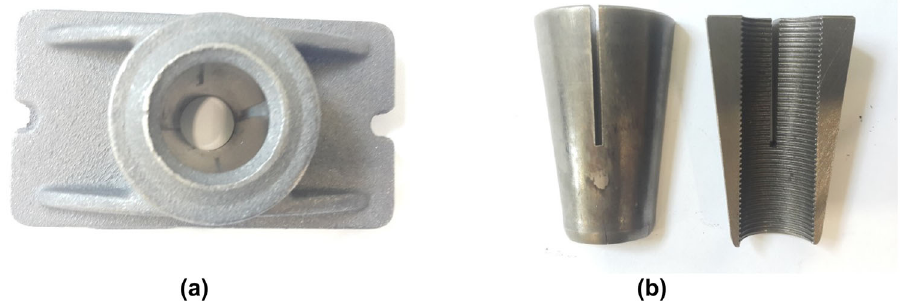
Fig. 10 Bare anchor and wedge after fatigue testing in accordance with KCI-P101 and ETAG 013. a Bare single-strand anchor and b two-piece wedge.